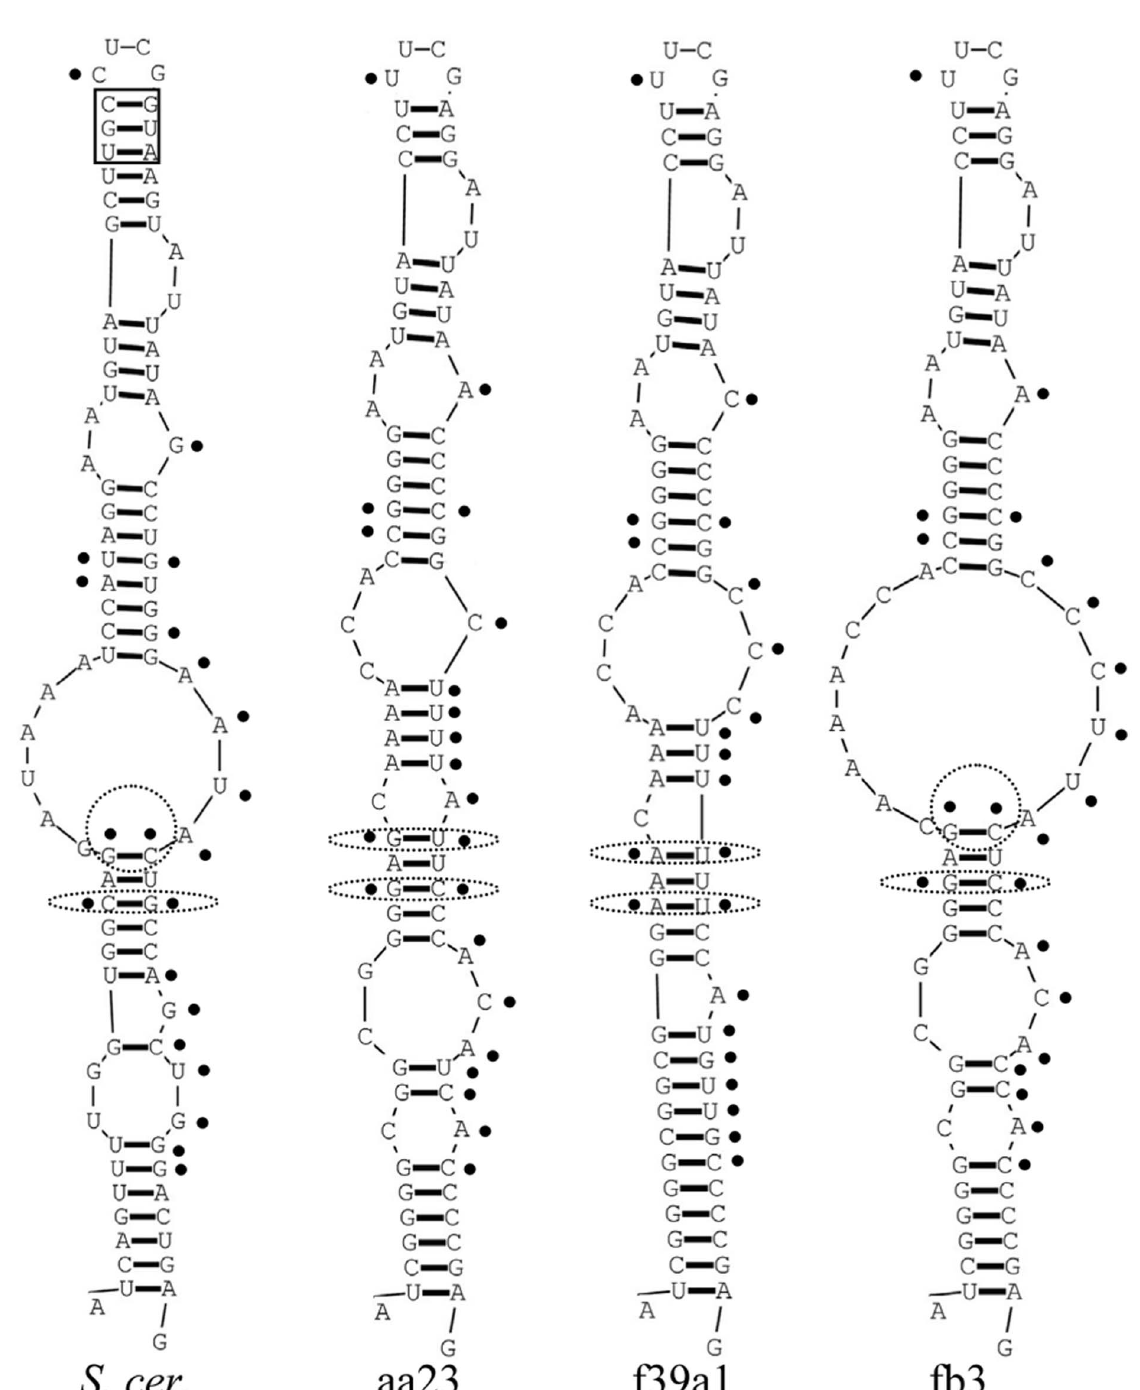
Figure 3. Predicted secondary structures of D2 hairpin-stem loops. Only examples of the M. andauensis (aa23) and the M. fructicola (f39a1 and fb3) clones are shown. Dots mark the variable sites and their equivalents in the S. cerevisiae molecule ( S. cer. ). The helical segment of the S. cerevisiae hairpin missing in Metschnikowia is boxed. doi:10.1371/journal.pone.0067384.g003 hairpins of S. cerevisiae and E. coli either (examples are shown in variability and grouping of variable sites in the back-folding Fig. 2). Structural variability was observed only in the stem parts, strands were also observed in the hairpin loops that included the apparently due to the variable sites that grouped in the back- VR2 segments (examples are shown in Fig. 3). These were formed folding strands of the helices. The only exception was site 103 from the equivalent of the large expansion segment of the S. cerevisiae molecule which has no counterpart in E. coli [32], so we which was in the complementary strand. Similar topological